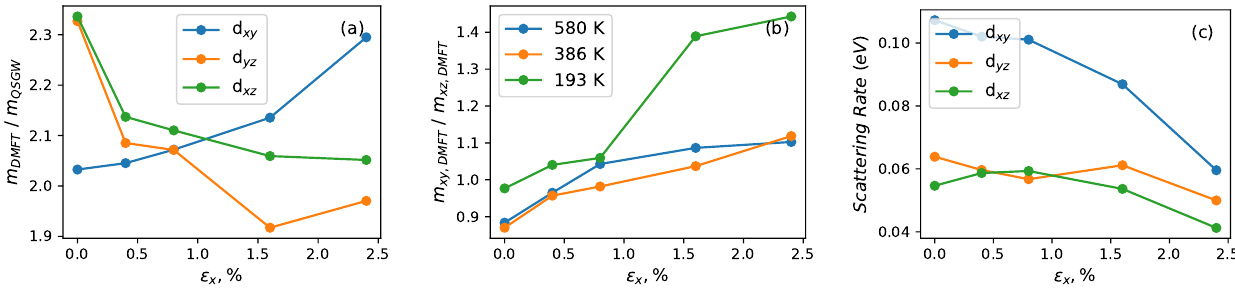
Figure 2. Effective masses and scattering rates: ( a ) The mass enhancement factors in DMFT (relative to the QS GW mass) are plotted in Ru- d xy , yz , xz channels. While the unstrained compound finds the heaviest electron mass for the electrons in the d xz orbital, under strain, the d xy mass becomes the heaviest. ( b ) We show the relative DMFT mass enhancement for the d xy orbital in comparison to d xz for all temperatures. ( c ) Scattering rates Γ are orbitally anisotropic, but under strain, they decrease in all orbital channels. For very large strains, the system becomes a better Fermi liquid metal; nevertheless, the orbital anisotropy, which is a typical signature of Hund’s metals, survives for the entire range of